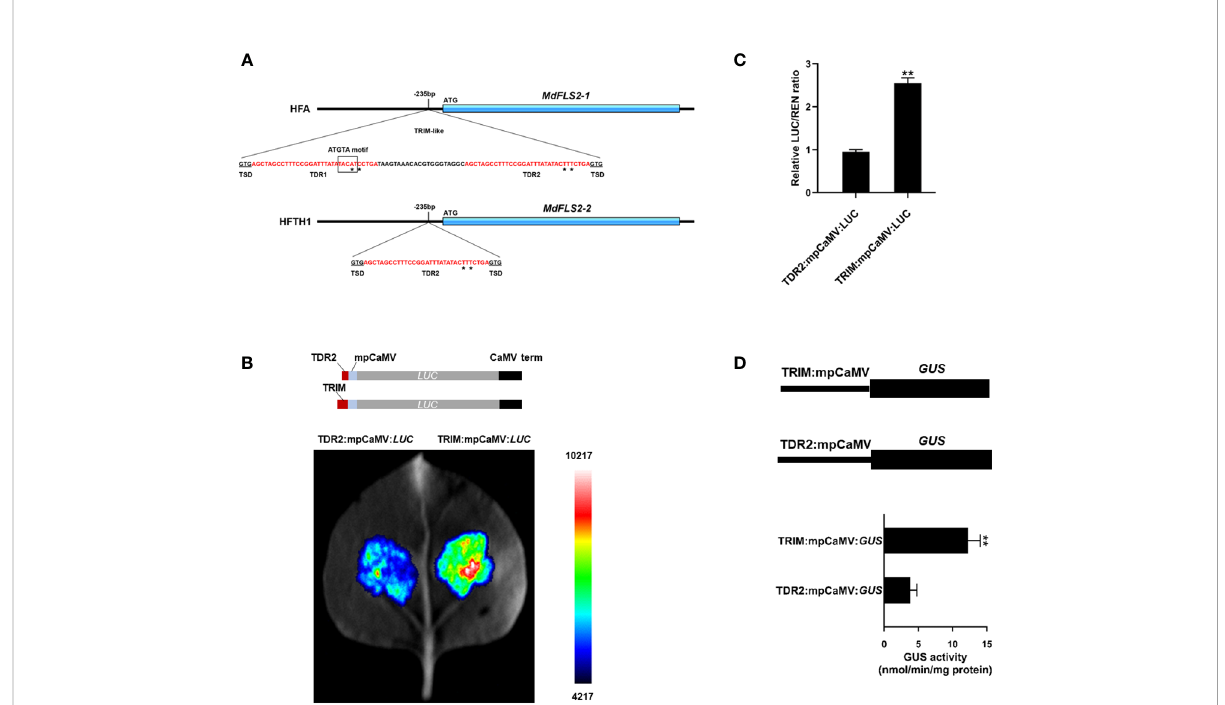
FIGURE 7 Insertion of the TRIM-like sequence affects the expression level of MdFLS2 allele. (A) Molecular structure of MdFLS2-1 from HF alternative genome (HFA) and of MdFLS2-2 from HFTH1 reference genome with fl anking sequence. The TRIM-like sequence contains the following sequence features: TSD (black underlined), TDRs (red font), and intermediate sequence (black font). Base differences between TDR1 and TDR2 are marked with asterisks. The black box indicates the ATGTA motif. (B) Transient expression analysis revealed that TRIM-like sequence insertion could signi fi cantly increase the expression level of luciferase. Upper panel represents the TDR2:mpCaMV: LUC (up) and TRIM:mpCaMV: LUC (down) constructs, both containing the minimal promoter from the cauli fl ower mosaic virus (mpCaMV), luciferase ORF, and cauli fl ower mosaic virus terminator (CaMV term), to which the TDR2 sequence and TRIM-like sequence are respectively added. Lower panel indicates luciferase assay of Nicotiana benthamiana leaves 72 h after infection with Agrobacterium strains containing TDR2:mpCaMV:LUC (left) and TRIM:mpCaMV: LUC (right). (C) The relative ratio of LUC/REN for both TDR2:mpCaMV: LUC and TRIM:mpCaMV: LUC . Values are the means ± SD of three biological replicates (Student ’ s t-tests, ** P < 0.01). (D) GUS activity in the transiently transformed N. benthamiana leaves with constructs TRIM:mpCaMV:GUS and TDR2:mpCaMV:GUS under normal conditions. The mean ± SD of biological triplicates were taken for every value. Asterisks denote signi fi cant differences by Student ’ s t-test (** P <